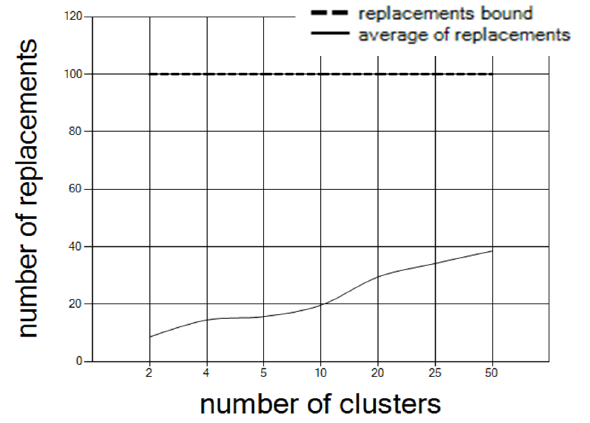
Figure 9. Increase in the number of replacements with an increase in the number of clusters.